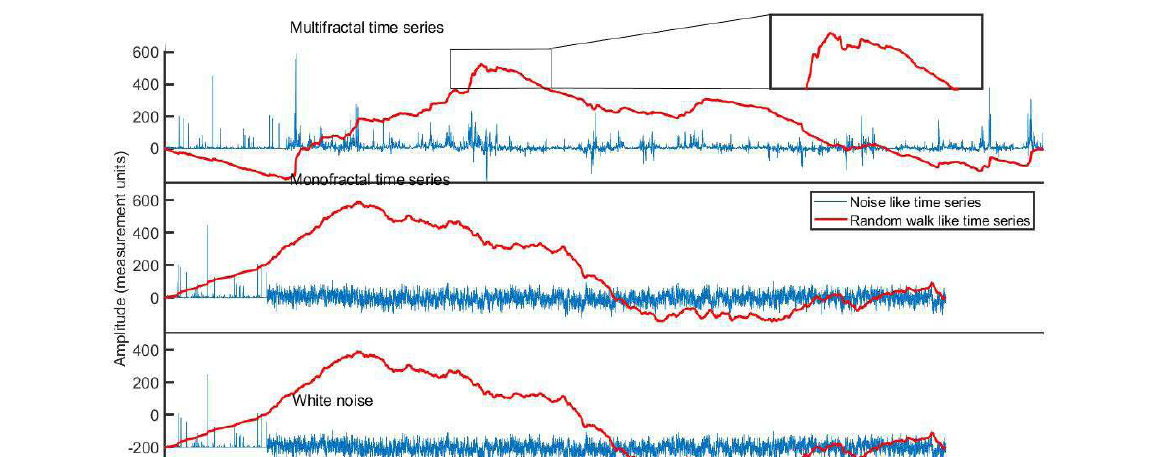
Figure 1. Multifractal, monofractal, and white noise like time